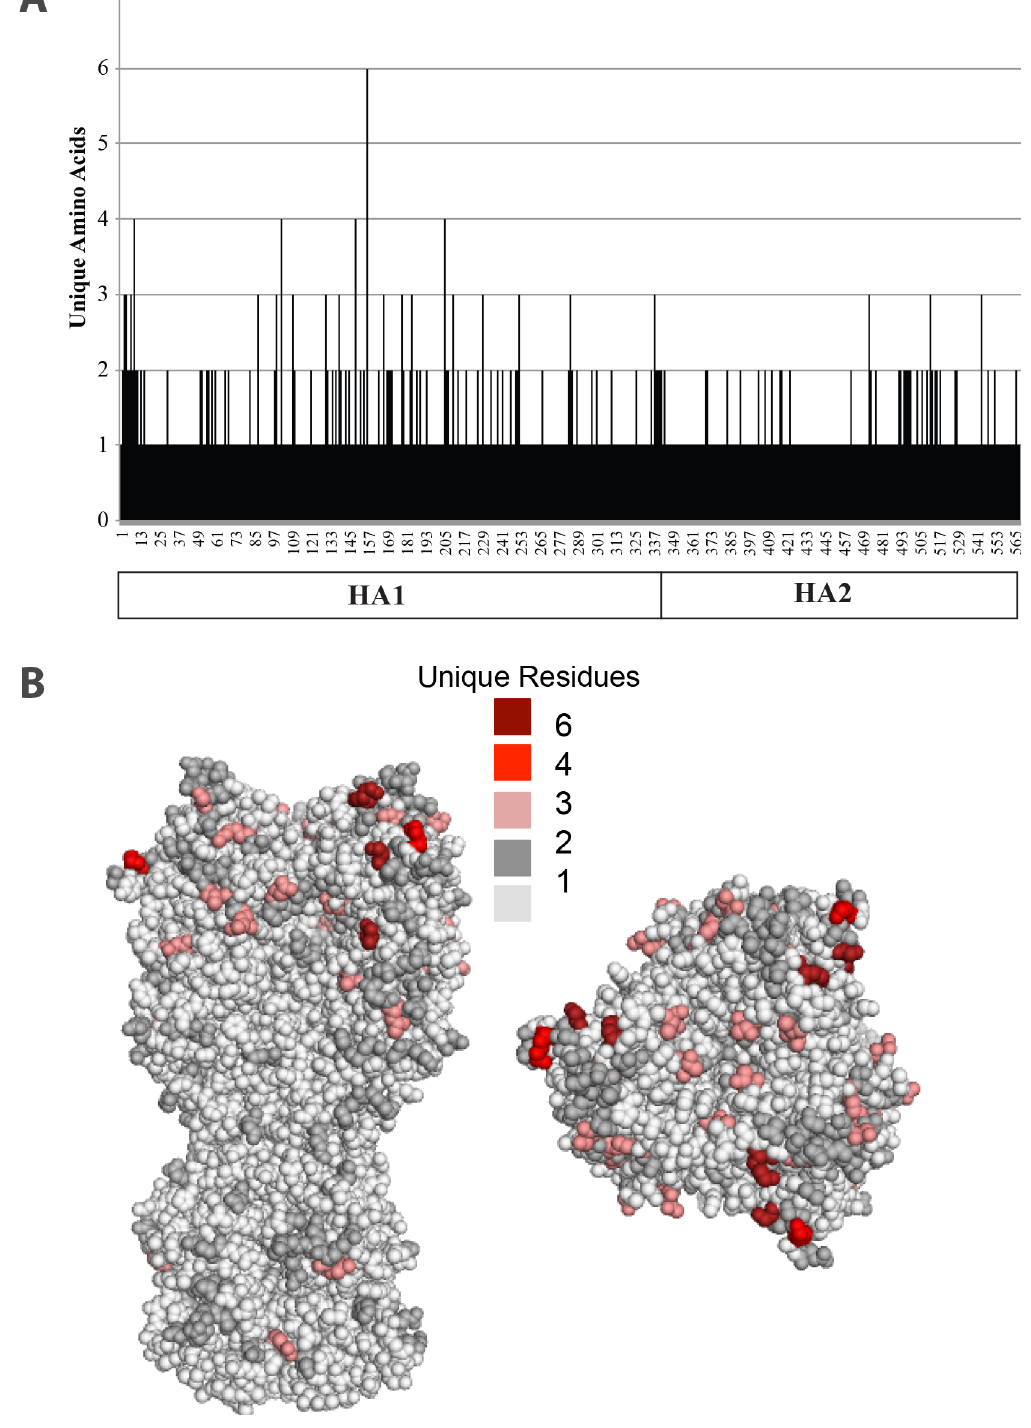
Fig 3. Amino acid substitutions in clade 2.3.4.4 H5NX viruses. (A) Number of unique amino acids found at each position (1 – 568) across H5NX viruses. HA1 and HA2 regions of the hemagglutinin protein are indicated in box. (B) Mapping of unique amino acids onto 3D reconstruction of H5N1 HA. Number of unique amino acids found at each amino acid position is colored as depicted in legend.